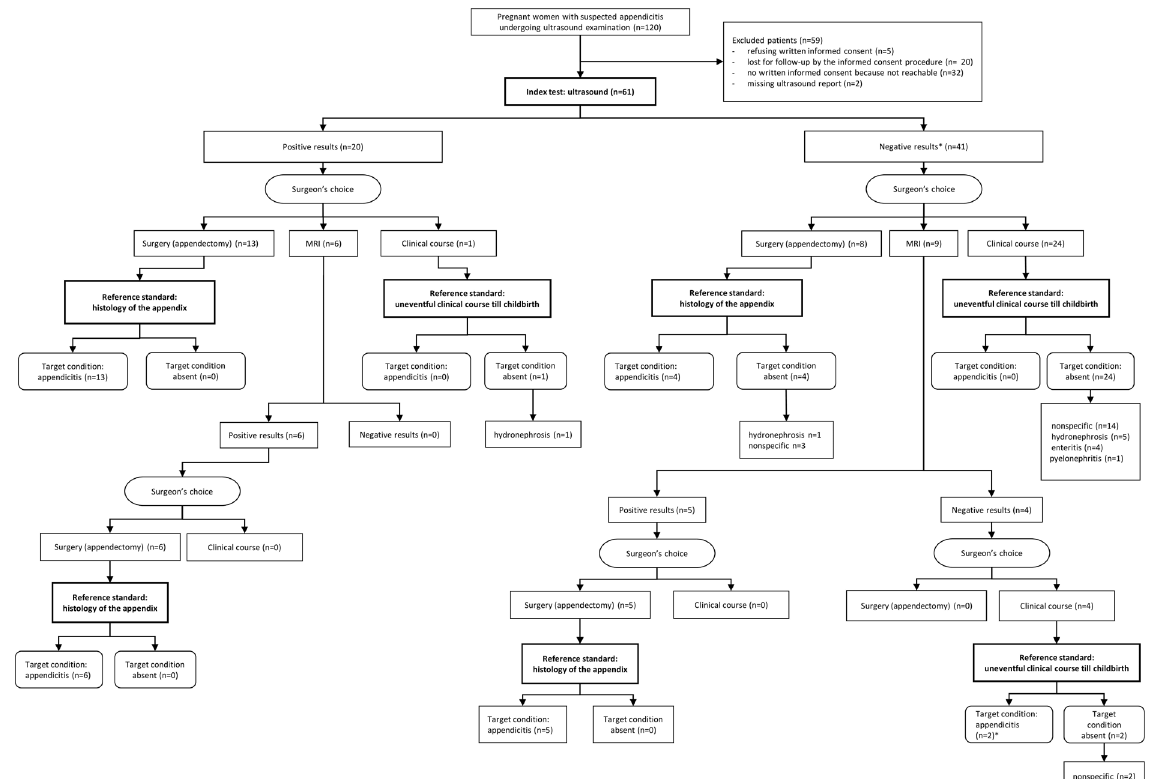
Figure 1. Patients’ inclusion flow chart and diagnostic STARD pathway. *Due to clinical deterioration both patients had an additional imaging study (one ultrasound, one magnetic resonance imaging) one day later, both with positive results. These two patients underwent surgery with histologically confirmed acute appendicitis. STARD, Standards for Reporting Diagnostic Accuracy; MRI, magnetic resonance